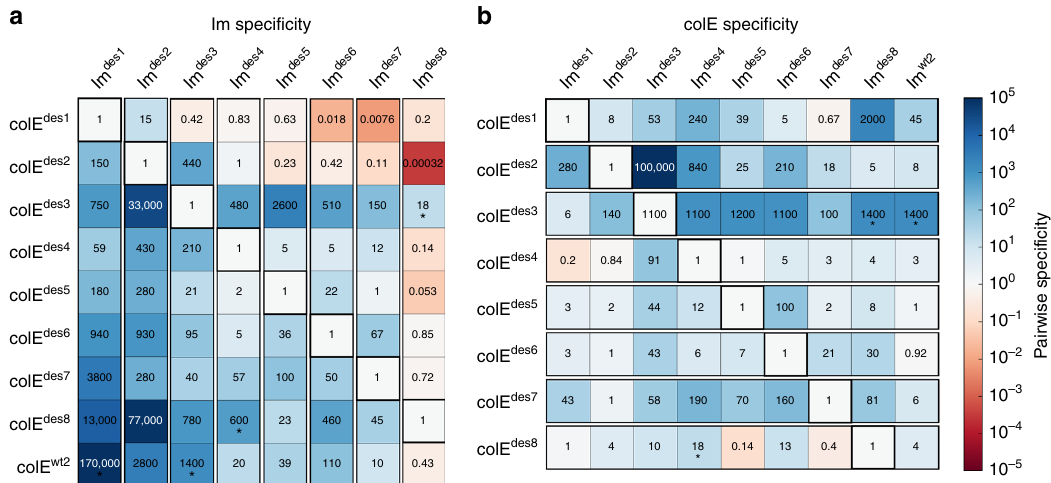
Fig. 4 Ultrahigh speci fi city and multispeci fi city among the designed pairs. Pairwise speci fi city values represent the fold-change in af fi nity of a the Im and b colE proteins against each non-cognate counterpart relative to the cognate af fi nity (assigned a value of 1) according to Eq. (1). Values marked with an asterisk represent lower bounds of pairwise speci fi city, as the experimentally measured interaction af fi nity exceeded 10 5 nM